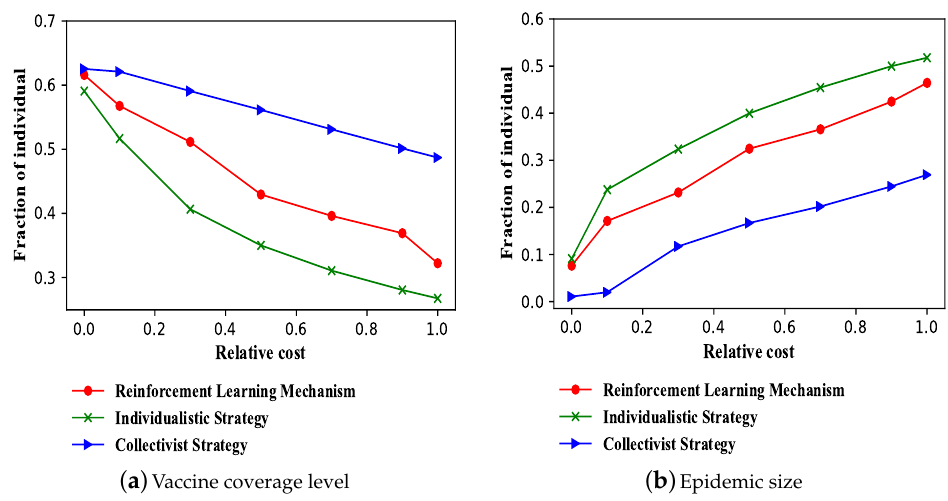
Figure 5. The comparison of results between reinforcement learning mechanism and two strategies. The vaccine coverage level is inversely proportional to c , and the epidemic size is directly proportional to c . In addition, we can find that collectivist strategy can always maintain the optimal result. Compared with the individualistic strategy, the reinforcement learning mechanism that taking collectivism into consideration has obtained better results under the same c